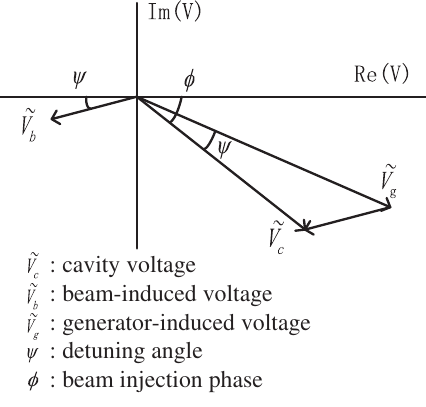
FIG. 29. Voltage phasors for a beam-loaded